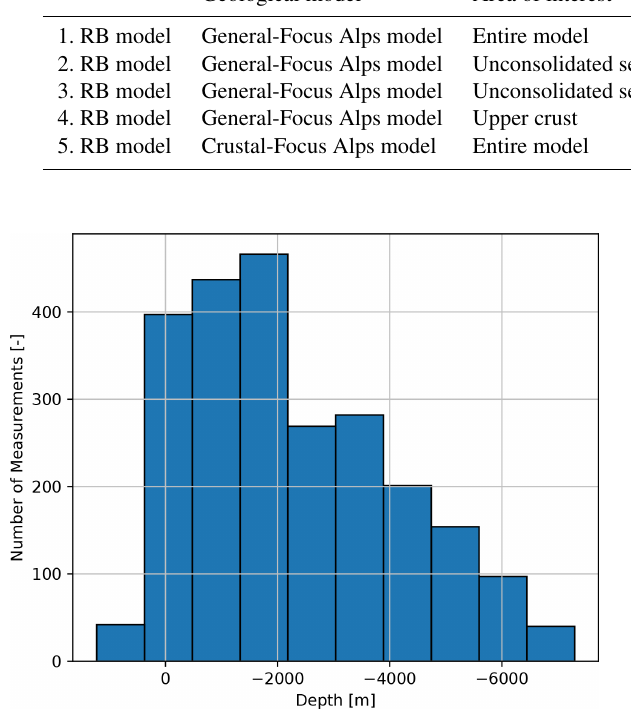
Figure 14. Distribution of the measurements according to